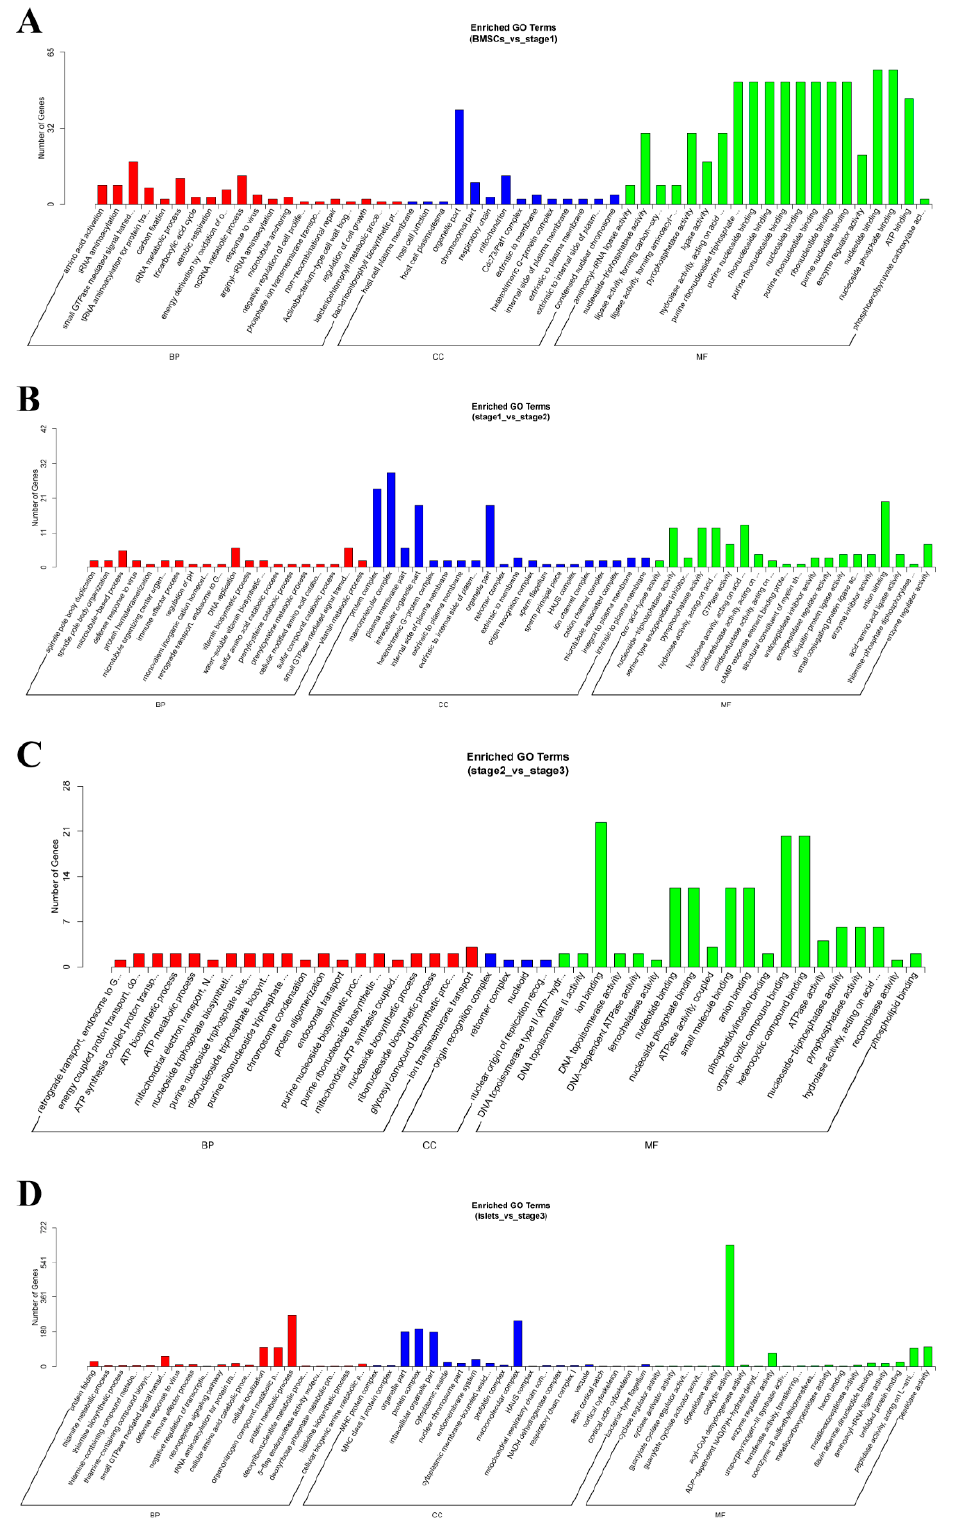
Figure 4. The Gene Ontology (GO) analysis of colocalized genes of differentially expressed lncRNAs. ( A ) The comparison of B vs S1. ( B ) The comparison of S1 vs S2. ( C ) The comparison of S2 vs S3. ( D ) The comparison of I vs S3.